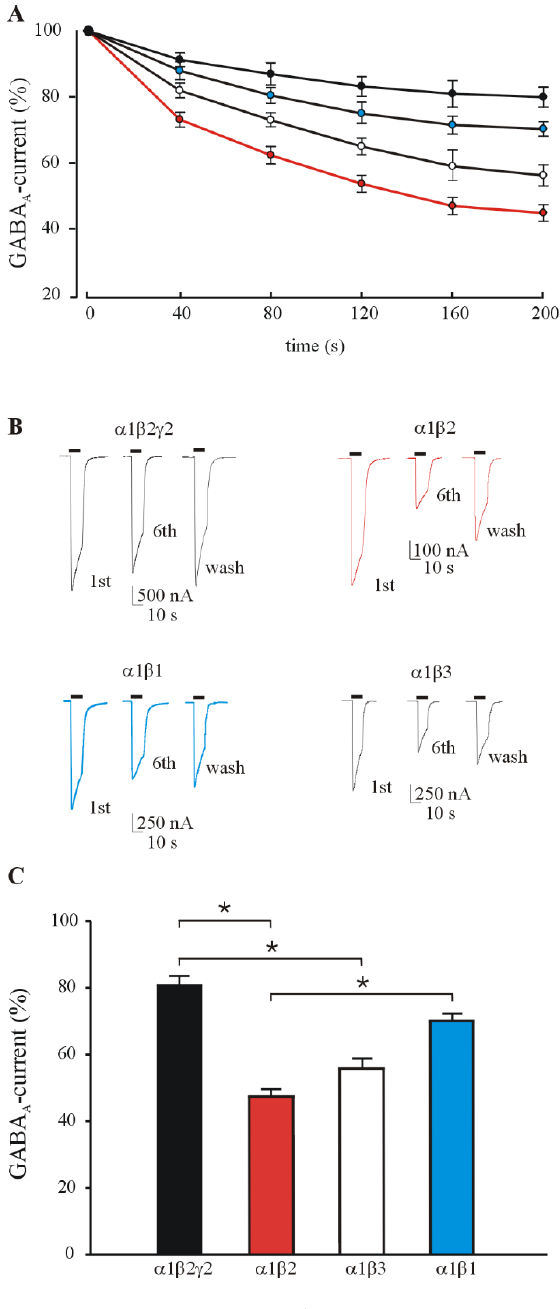
Figure 1. GABA current rundown in oocytes expressing different GABA A R subunit combinations. ( A ) Time course of GABA current rundown relative to α 1 β 2 γ 2( • ), α 1 β 1( • ), α 1 β 2( • ), α 1 β 3(